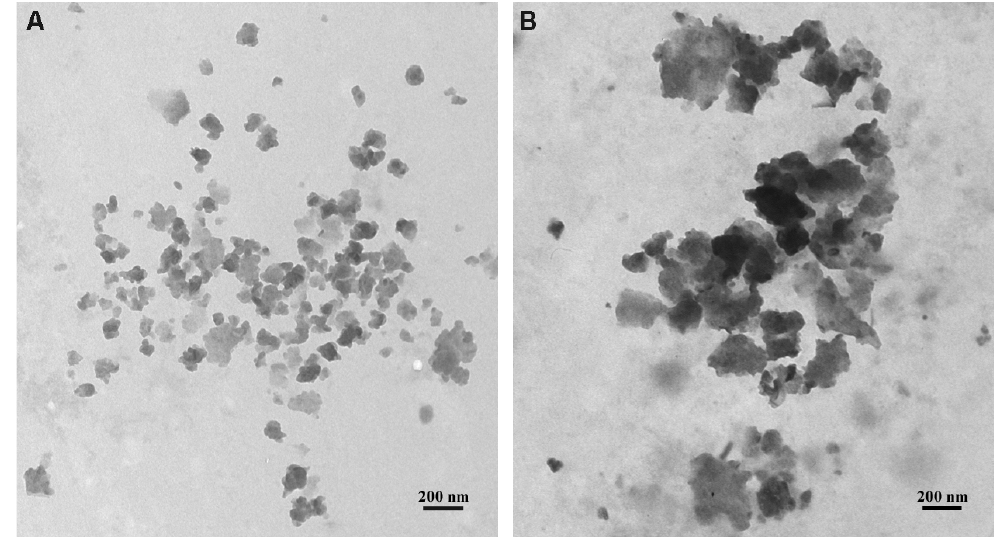
Figure 3. Representative transmission electron microscopy images of ( A ) TOP60 and ( B ) BOTTOM60 GNPs. Both nanoparticles show a similar irregular morphology while exhibiting a different lateral size. TOP60 GNPs have an average lateral dimension of 70 nm, while BOTTOM60 GNPs of 120 nm. Furthermore, BOTTOM60 nanoparticles exhibit a pronounced tendency to entangle with each other in a random manner, producing multilayer aggregates more frequently than TOP60 ones.